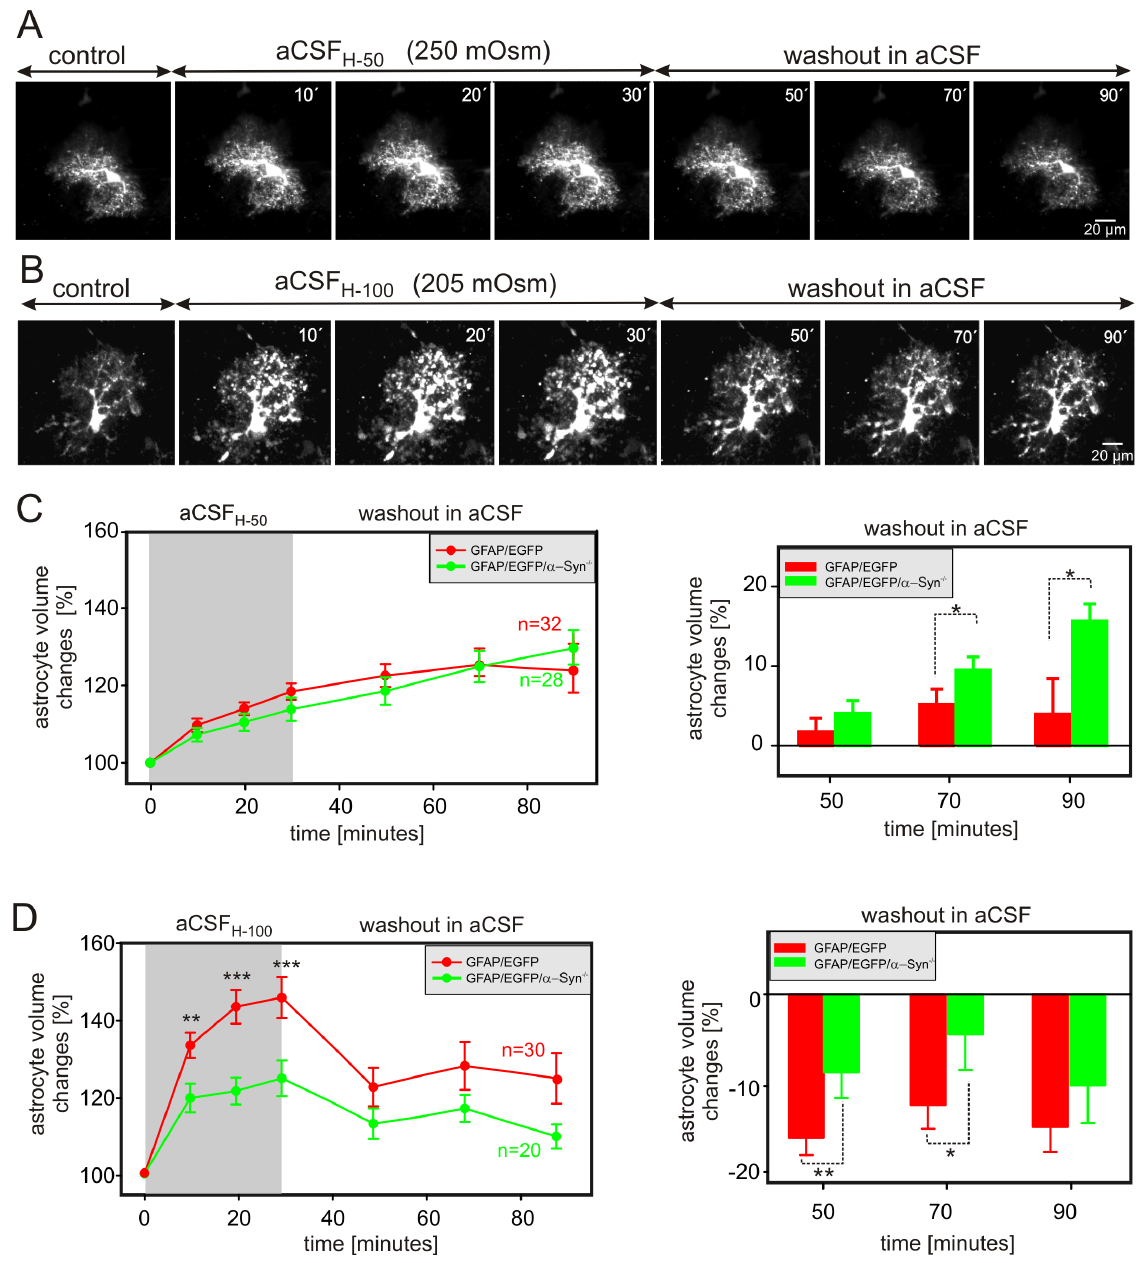
Figure 4. Astrocytic volume changes in the cortex of GFAP/EGFP and GFAP/EGFP/ a -Syn 2 / 2 mice during hypoosmotic stress. ( A, B ) Superimposed confocal images of EGFP-labeled cortical astrocytes from GFAP/EGFP/ a -Syn 2 / 2 mice obtained in aCSF (control), during a 30-minute exposure to hypoosmotic stress of 250 mOsm/kg (aCSF H-50 ; A ) or 205 mOsm/kg (aCSF H-100 ; B ) and during a 60-minute washout. The astrocytic volume was quantified every 10 minutes during exposure to hypoosmotic stress and every 20 minutes during washout. ( C, D ) Time-dependent changes in the total astrocytic volume in GFAP/EGFP (red) and GFAP/EGFP/ a -Syn 2 / 2 mice (green) during a 30-minute exposure to aCSF H-50 ( C left ) or to aCSF H-100 ( D left ) and during a 60-minute washout. The changes of astrocytic volume during washout were evaluated in each individual cell and expressed as an average percent of cell volume increase/decrease related to the maximal volume after 30 minutes of aCSF H-50 ( C right ) or aCSF H-100 ( D right ) exposure; these values were set as 0%. Note that a -syntrophin deletion results in smaller astrocyte swelling only during aCSF H-100 application and in smaller volume changes following mild hypoosmotic stress. Asterisks indicate significant (*, p , 0.05), very significant (**, p , 0.01) and extremely significant (***, p , 0.001) differences between GFAP/EGFP and GFAP/EGFP/ a -Syn 2 / 2 mice.